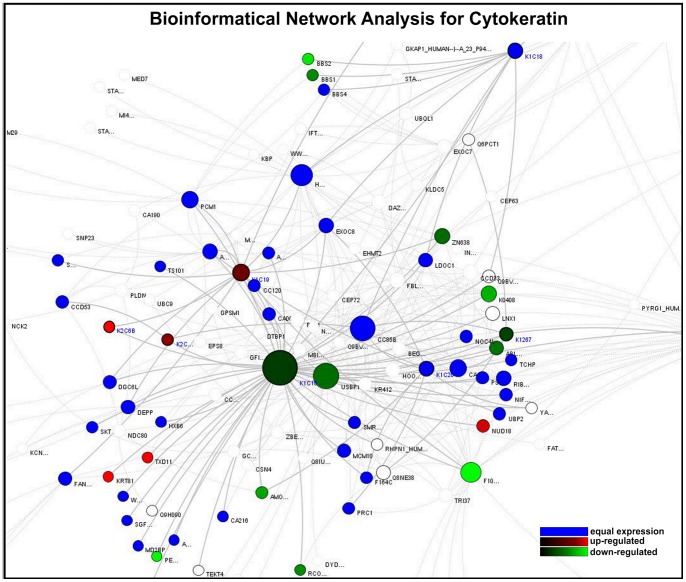
Bioinformatical network analysis for cytokeratin.Proteins are the nodes and the edges are protein activation/inactivations, such as phosphorylation and dephosphorylation across a set of proteins. The cytokeratin analysis reveals an up-regulation of Keratin 6 A and B, Keratin18, Keratin 19 and Keratin 81. In our data, genes for Keratin 15, FAM107A, BBS1 and Peripherin were down-regulated in cholesteatoma. Colors: red: up-reglated genes within cholesteatoma compared to external auditory skin; green: down-regulated genes within cholesteatoma compared to external auditory skin; grey: the gene for the protein is not in the microarray; Node-Size: The “Node Ranking” describes the number of interactions. The bigger the nodes, the more interactions are represented for the protein in the network.